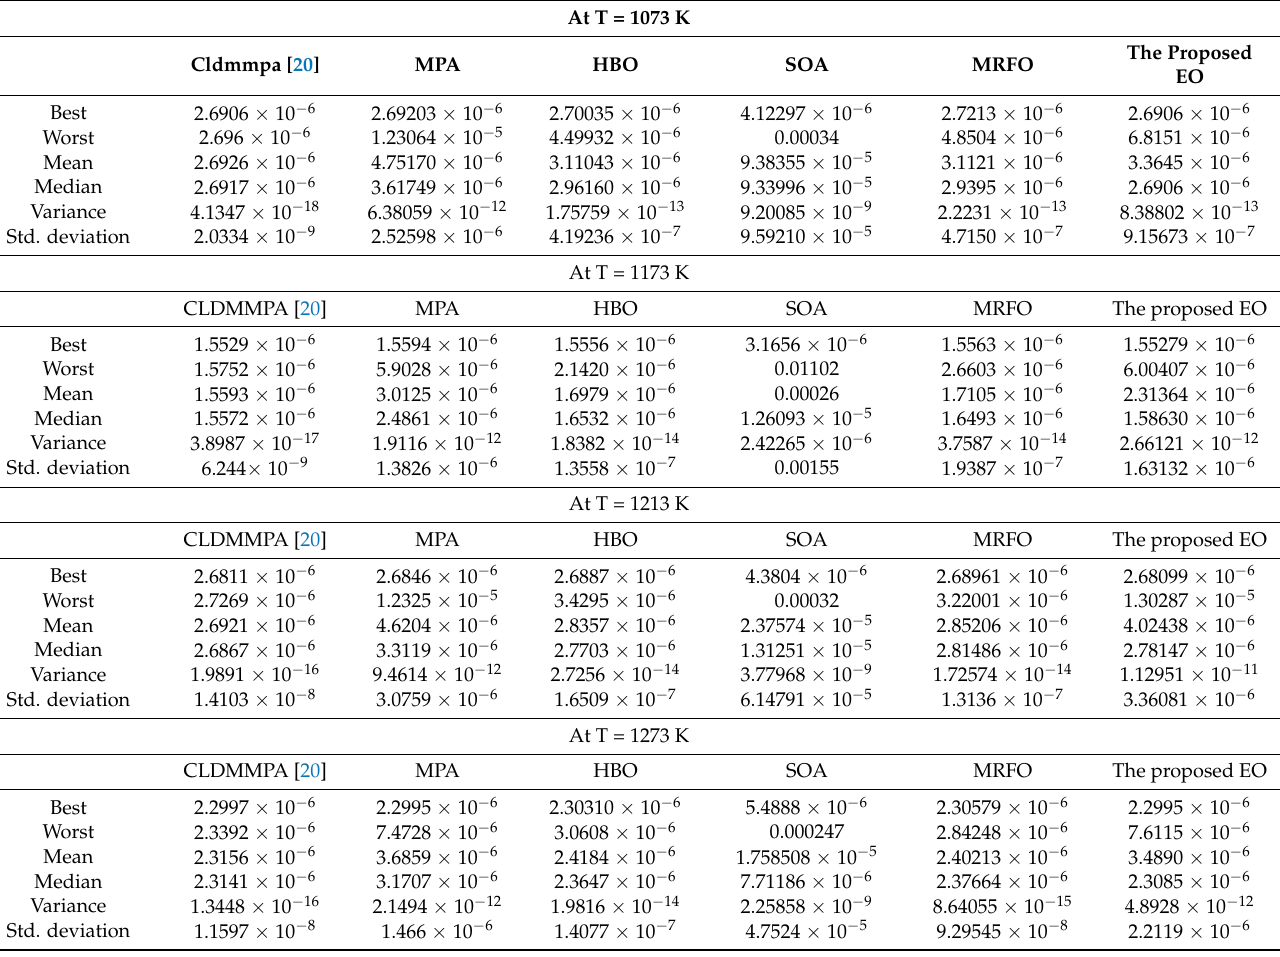
Table 5. Statistical parameters (best, worst, mean, median, variance, and standard deviation) of all optimizers used for steady-state SOFC